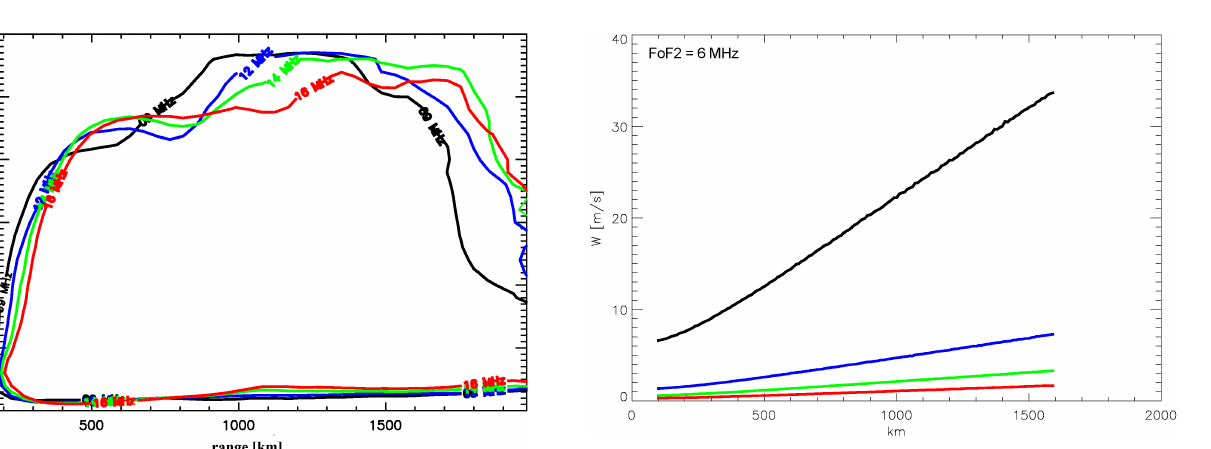
Fig. 5. Range-velocity distribution of echoes associated with the database used for the study described in Valli`eres et al. (2003). Con- tours representing a level of 50% of the occurrence are plotted for 9MHz (black), 12MHz (blue), 14MHz (green) and 16MHz (red).